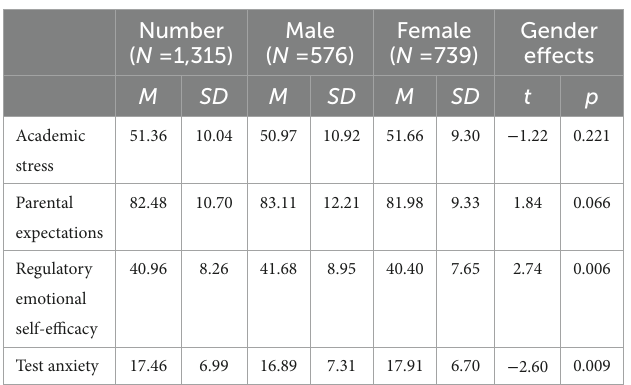
TABLE 1 The means, standard deviations and gender effects of academic stress, parental expectations, regulatory emotional self-efficacy and test anxiety.